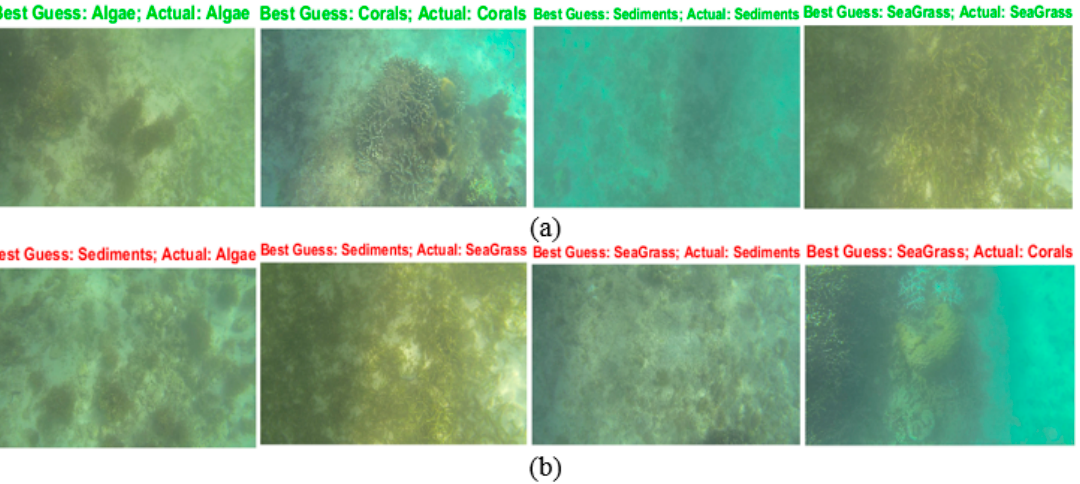
Figure 6. Samples of resulted processed benthic cover images ( a ) correctly categorized images ( b ) wrong categorized images over the Shiraho area.